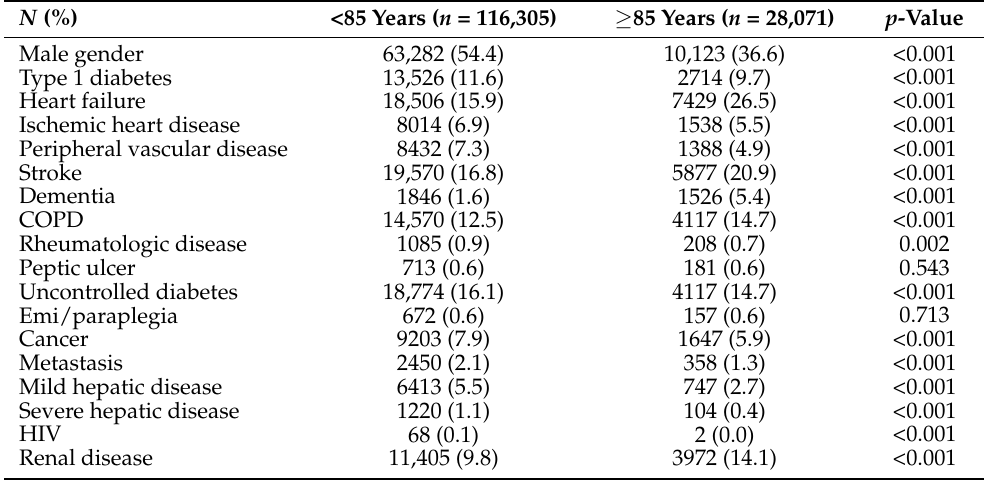
Table 1. Comparison of characteristics between patients over and below 85 years of age.